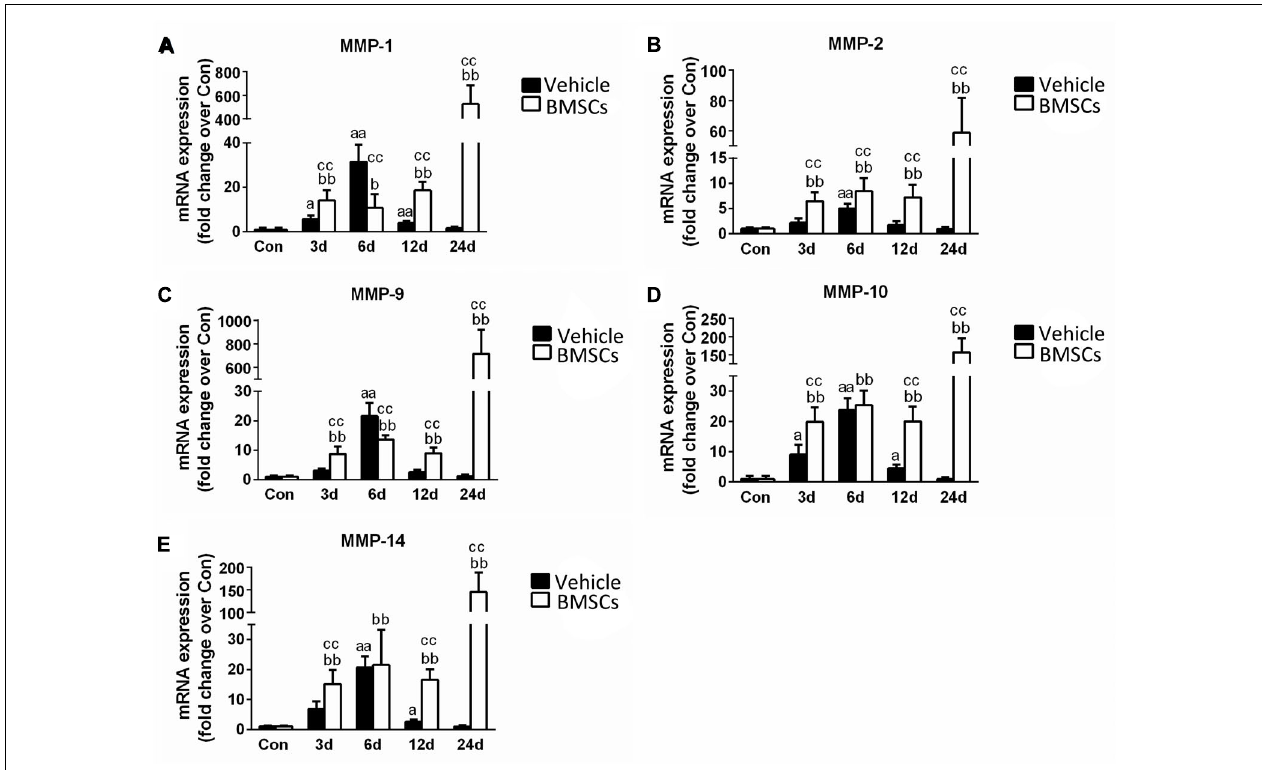
FIGURE 9 | The effects of BMSCs treatment on the expression of matrix metalloproteinase. Vehicle, muscle contusion and vehicle treated group; BMSCs, muscle contusion and BMSCs treated group. (A–E) The expression of MMPs after skeletal muscle injury. Data are means ± S.D., n = 8; a Significant difference from control, P < 0.05; aa P < 0.01. b Significant difference from control, P < 0.05; bb P < 0.01. c Significant difference from the same time points of group vehicle, c P < 0.05; cc P < 0.01. Transplantation of BMSCs resulted in significant more increases of MMPs in injured gastrocnemius muscle.